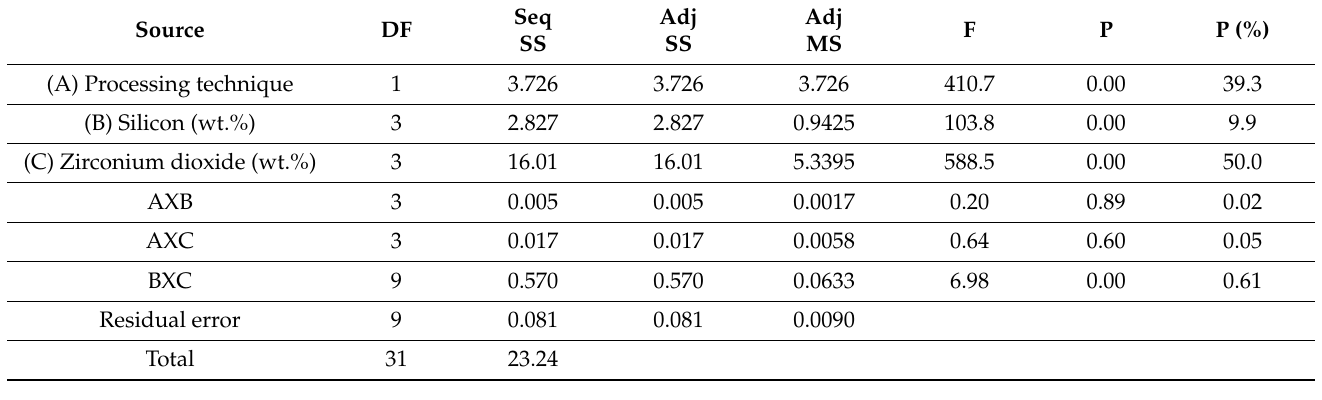
Table 7. ANOVA for SN ratios.